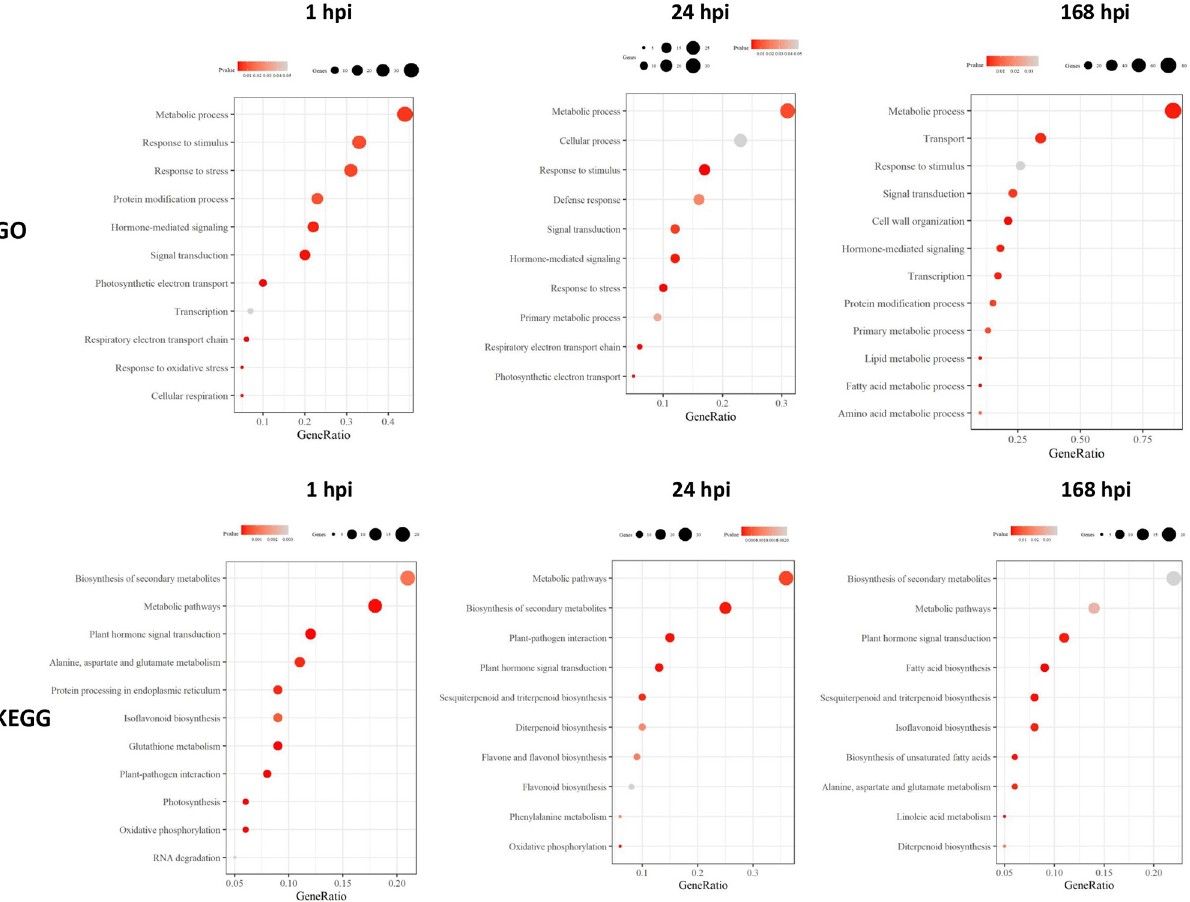
Fig 4. Enriched GO and KEGG terms among the statistically significant differentially expressed genes at 1, 24 and 168 h postinoculation (hpi) with D . solani . The genes were chosen based on NOISeq analysis with probability > 0.8, p-value < 0.05 and fold change > 9 and < − 9.